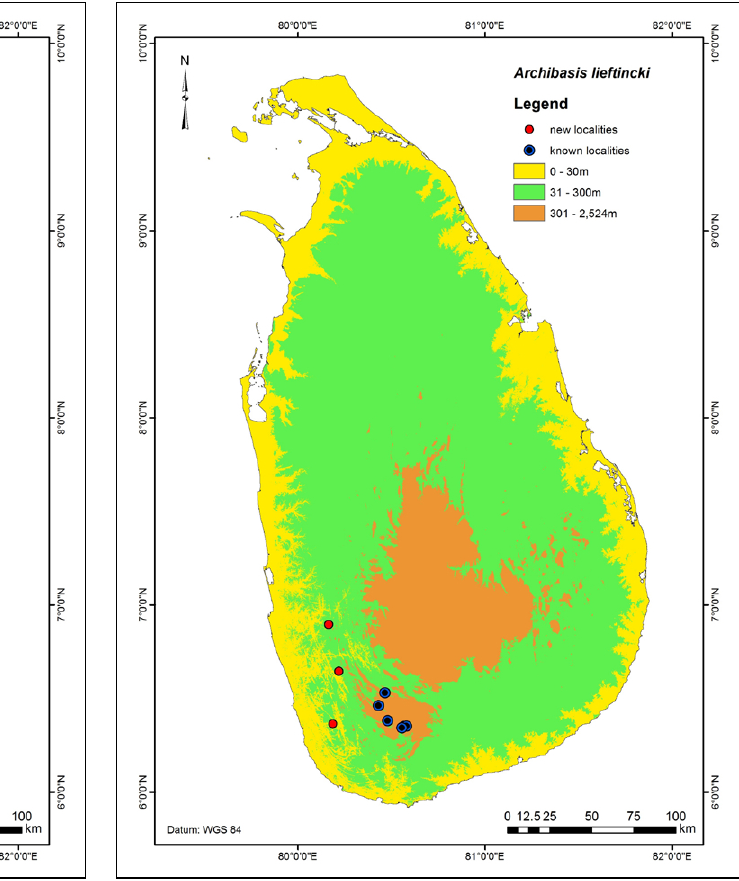
Figure 4. Distribution of Indolestes divisus with new localities. Figure 6. Distribution of Archibasis lieftincki with new localities.